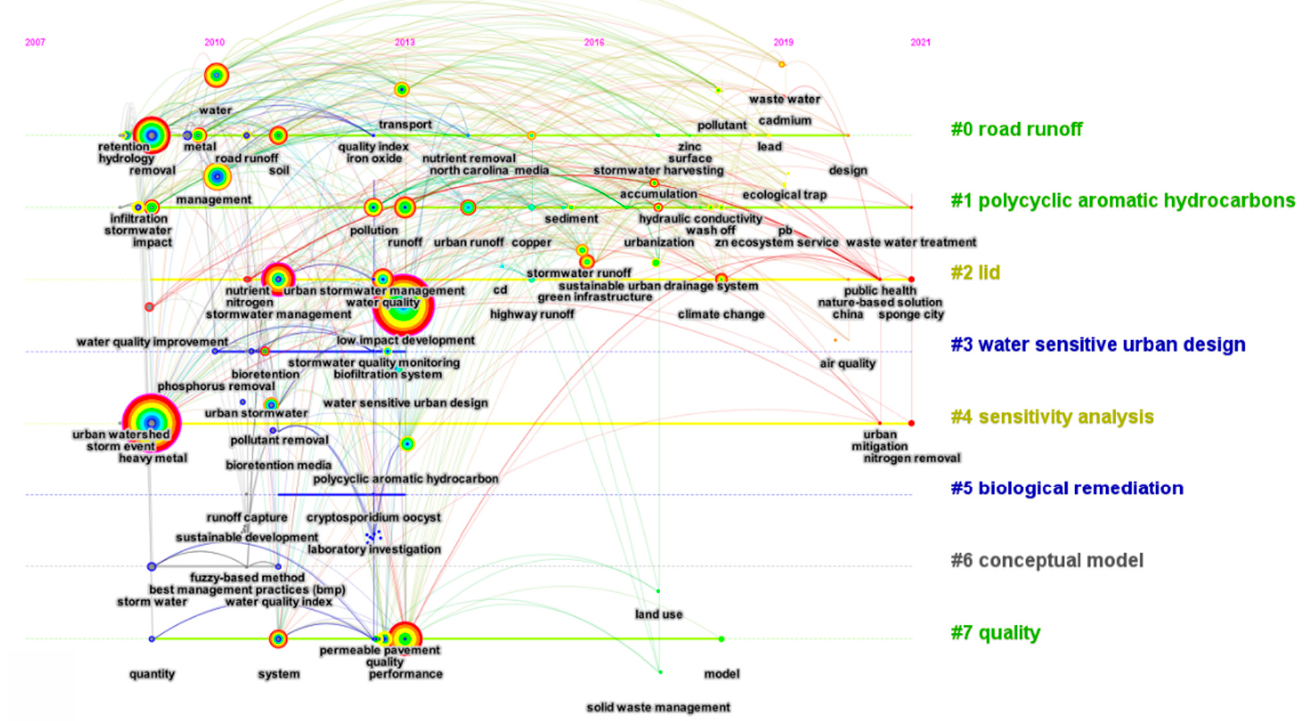
Figure 12. Environmental health keyword clustering timeline analysis.